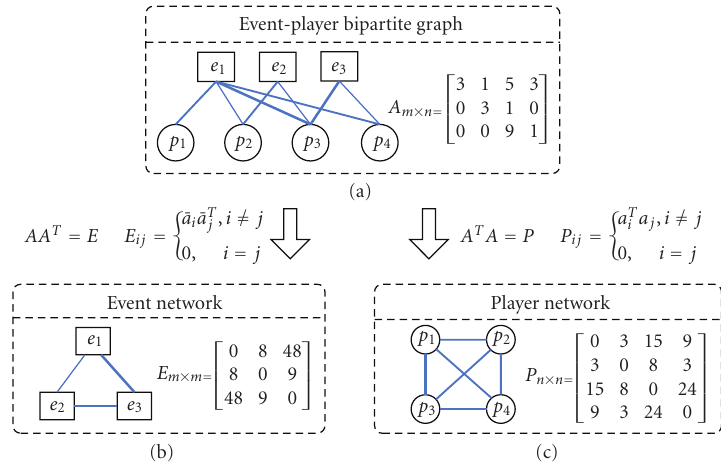
Figure 8: Graphical example of player and event network